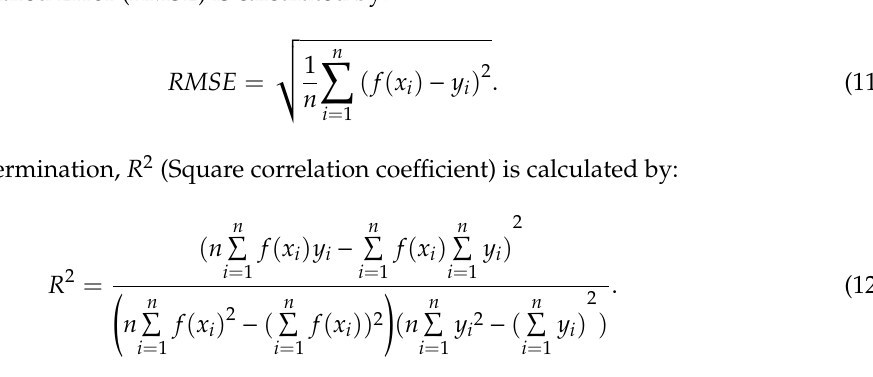
Figure 3. SVR prediction modeling algorithm flow diagram.